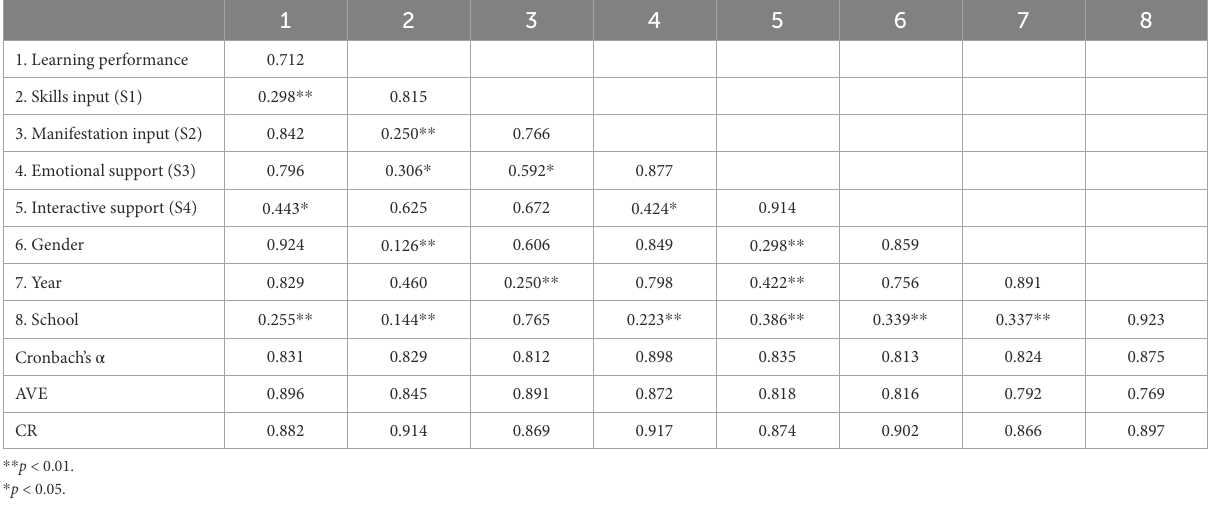
TABLE 3 Scale measurement.